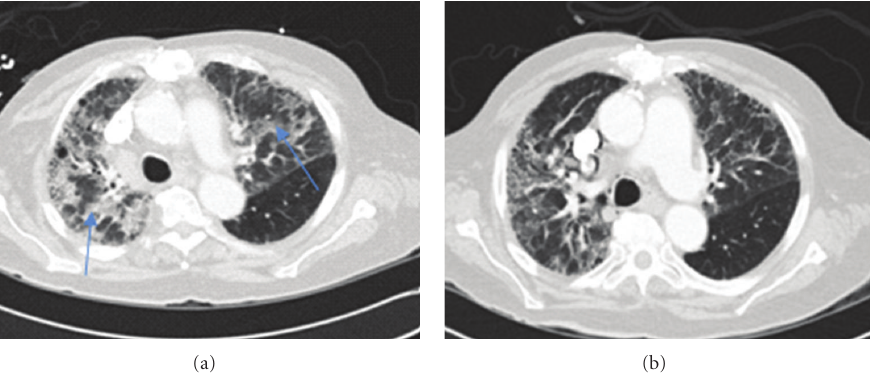
Figure 1: Computed tomography (CT) of the chest at the initial presentation of patient on the fifth day following rituximab treatment (a) and 20 days after initiation of steroid treatment (b). Arrows show bilateral pulmonary patchy